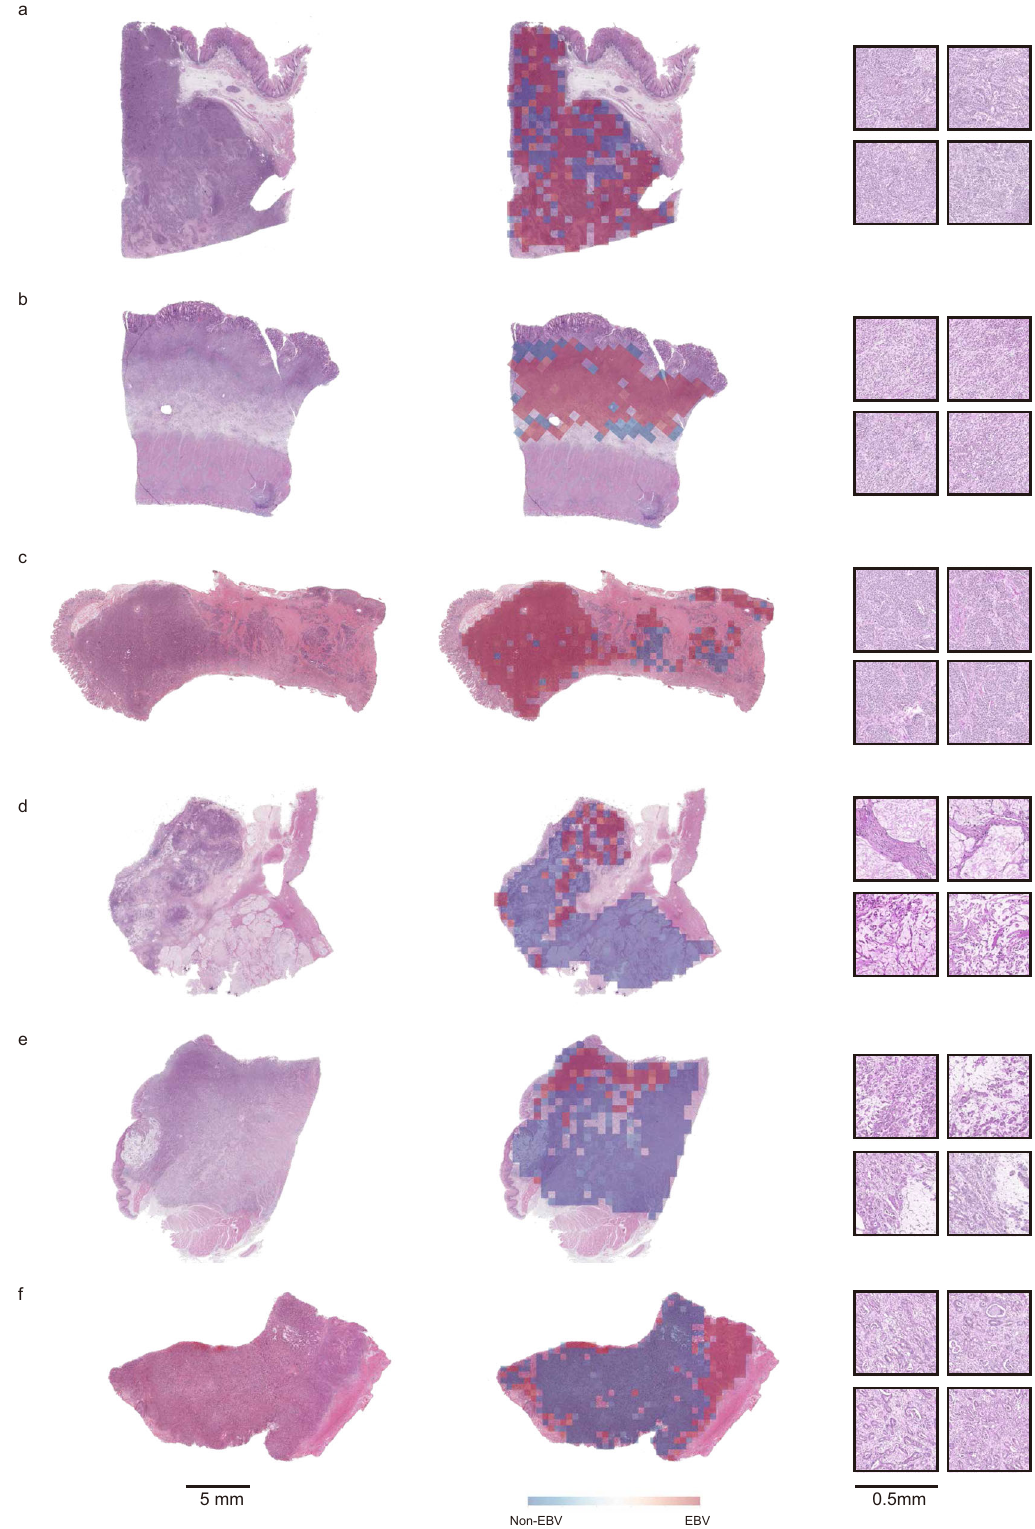
Methods Study participants . This study was approved by the Institutional Review Board of Sun Yat-sen University Cancer Center. To develop EBVNet, we used three pathological image datasets, including the internal dataset from a single medical center (Internal-STAD), the external dataset from multiple medical centers (MultiCenter-STAD), and the well-known public dataset from The Cancer Gen-